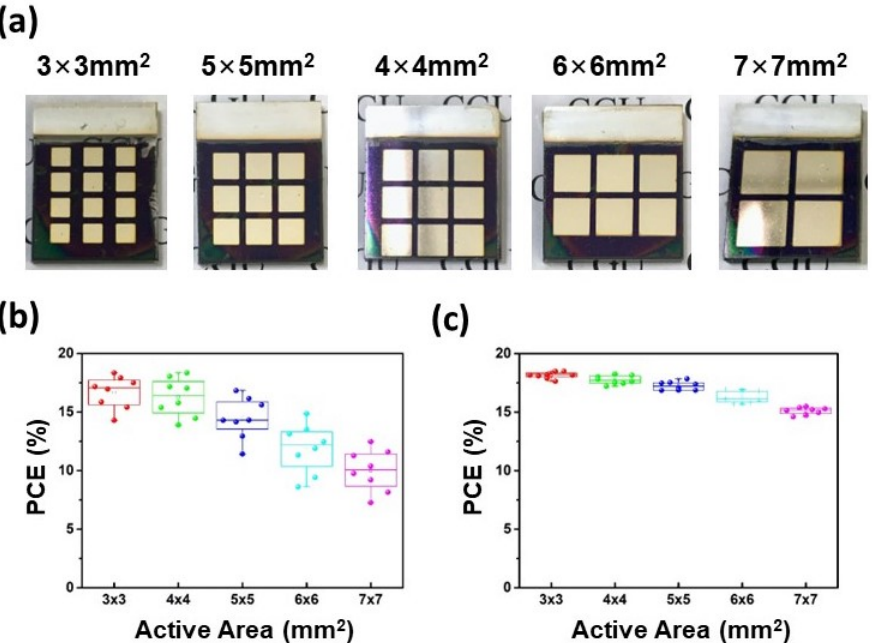
Figure 6. ( a ) Photos of perovskite devices with various active areas. ( b ) The area-dependent statis- tical performance of 1.0 mM Tween 20 PSCs fabricated by ( b ) the spin-coating method and ( c ) the thermal-assisted blade-coating method. assisted blade-coating method.